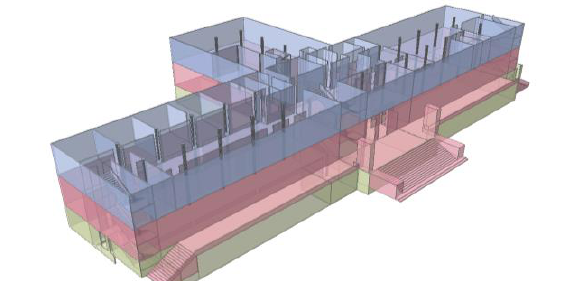
Figure 2. 3D Model of Main Library in UP